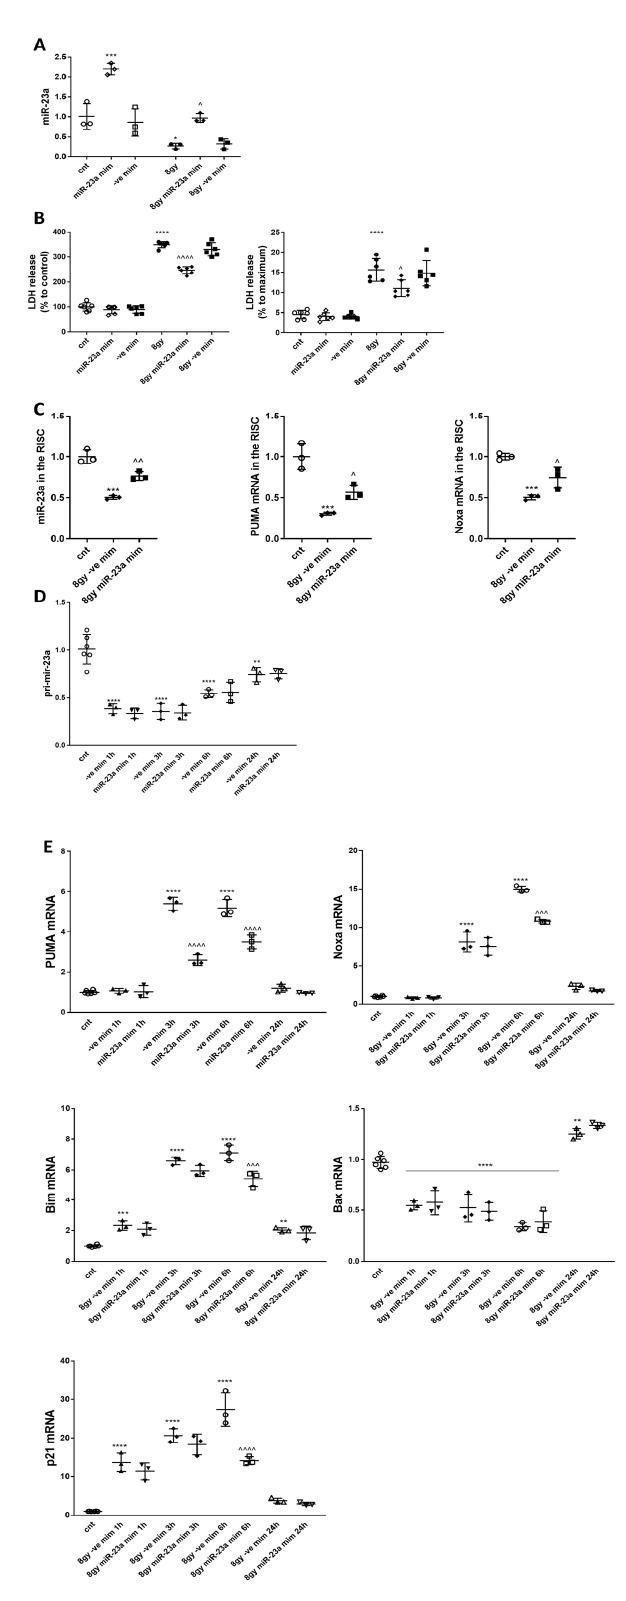
Figure 5. miR-23a-3p mimic reverses the decrease of endogenous miR-23a-3p in irradiated primary cortical neurons and attenuates neuronal cell death. RCNs were transfected with miR-23a-3p mimics and negative control mimics before irradiation. At 3h after exposure to 8Gy, neurons were harvested for RNA isolation. qPCR quantification of miR-23a-3p in a representative experiment ( A ). The